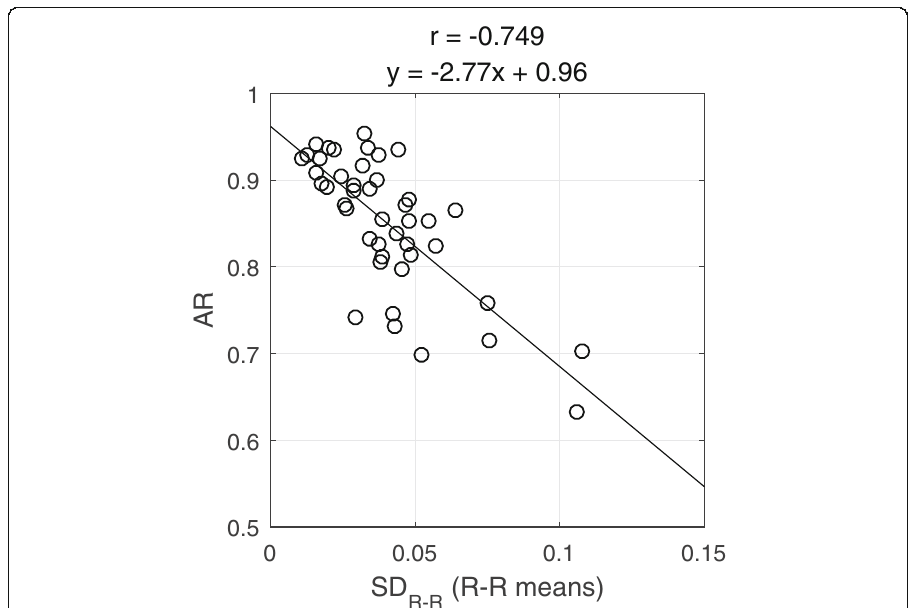
Fig. 2 Scatter plot of the R – R interval standard deviation (SD R-R ) vs. activity ratio (AR). Pearson ’ s correlation coefficient (r) and regression line equation are displayed